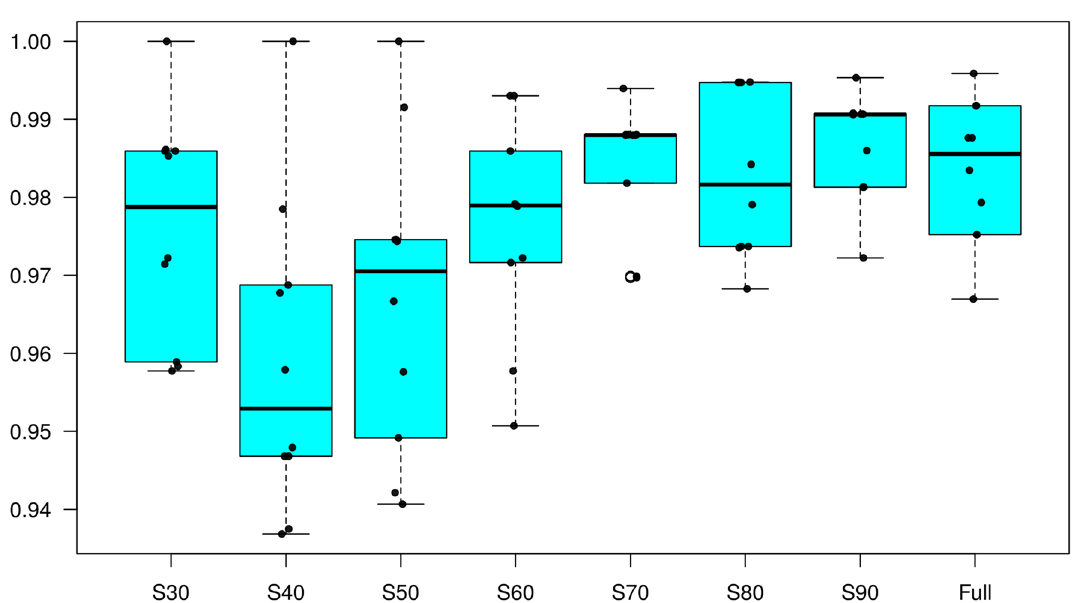
Figure 4. Boxplot of the overall successful assignment over different sampling (S) proportions of the data (30 to 100%) using DAPC. Median (black horizontal lines within the boxplots) over ten replicates (black